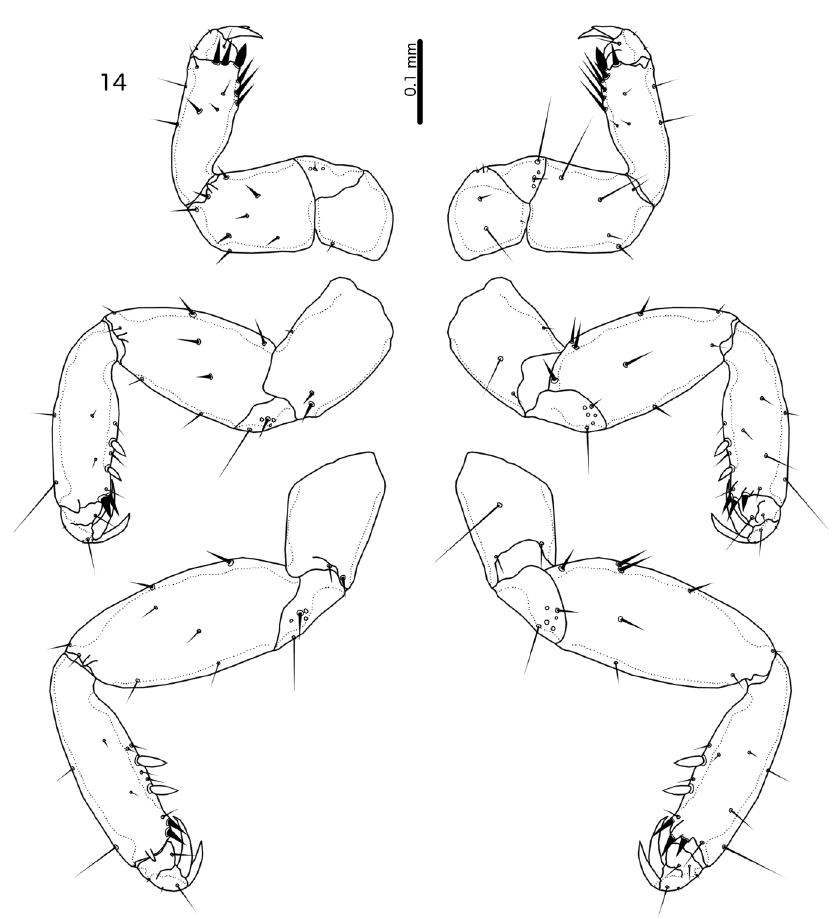
Fig. 14. Gallancyra dentata (Sugimoto, 1934) gen. et comb. nov. ex Gallus gallus (Linnaeus, 1758) (NHMUK010682393). Male legs I–III, dorsal and ventral views. Legs II and III distorted in all examined males, and here illustrated approximately; note that marginal and near-marginal setae (marked with small black circles) are illustrated on both dorsal and ventral side, as their exact placement is difficult to establish due to the distortion of the legs. Some setae on tibiae II–III appear hyaline in examined specimens, and have here been illustrated as